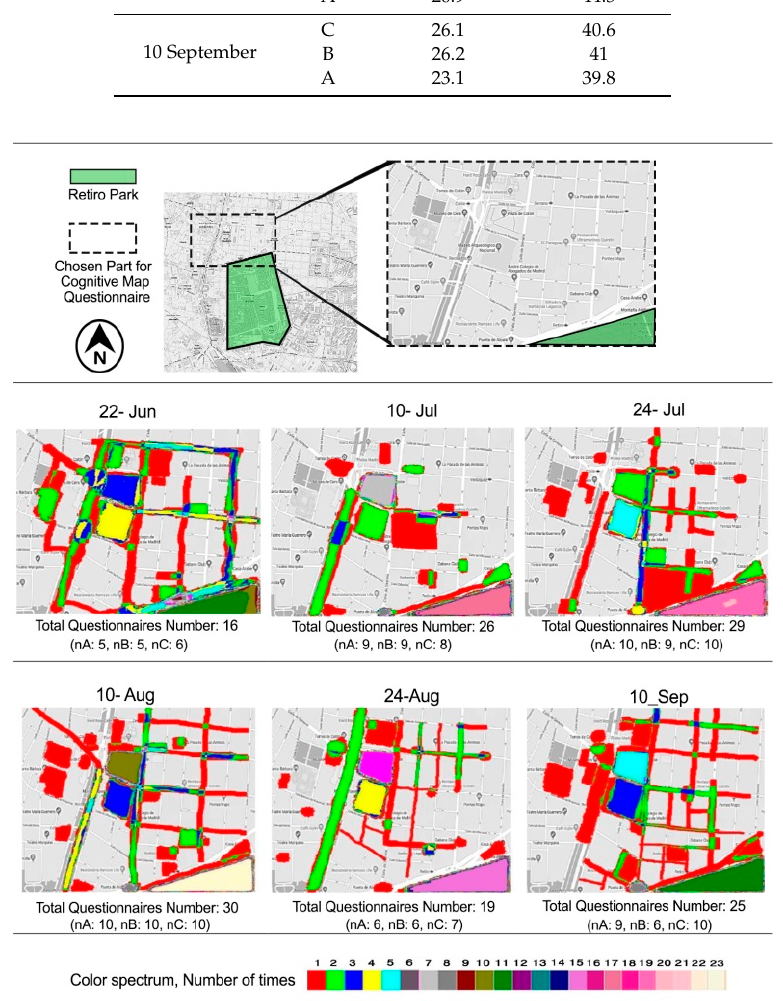
Figure 5. Cognitive map analyses using the AramMMA software [88] during six hot summer days of 2018 .